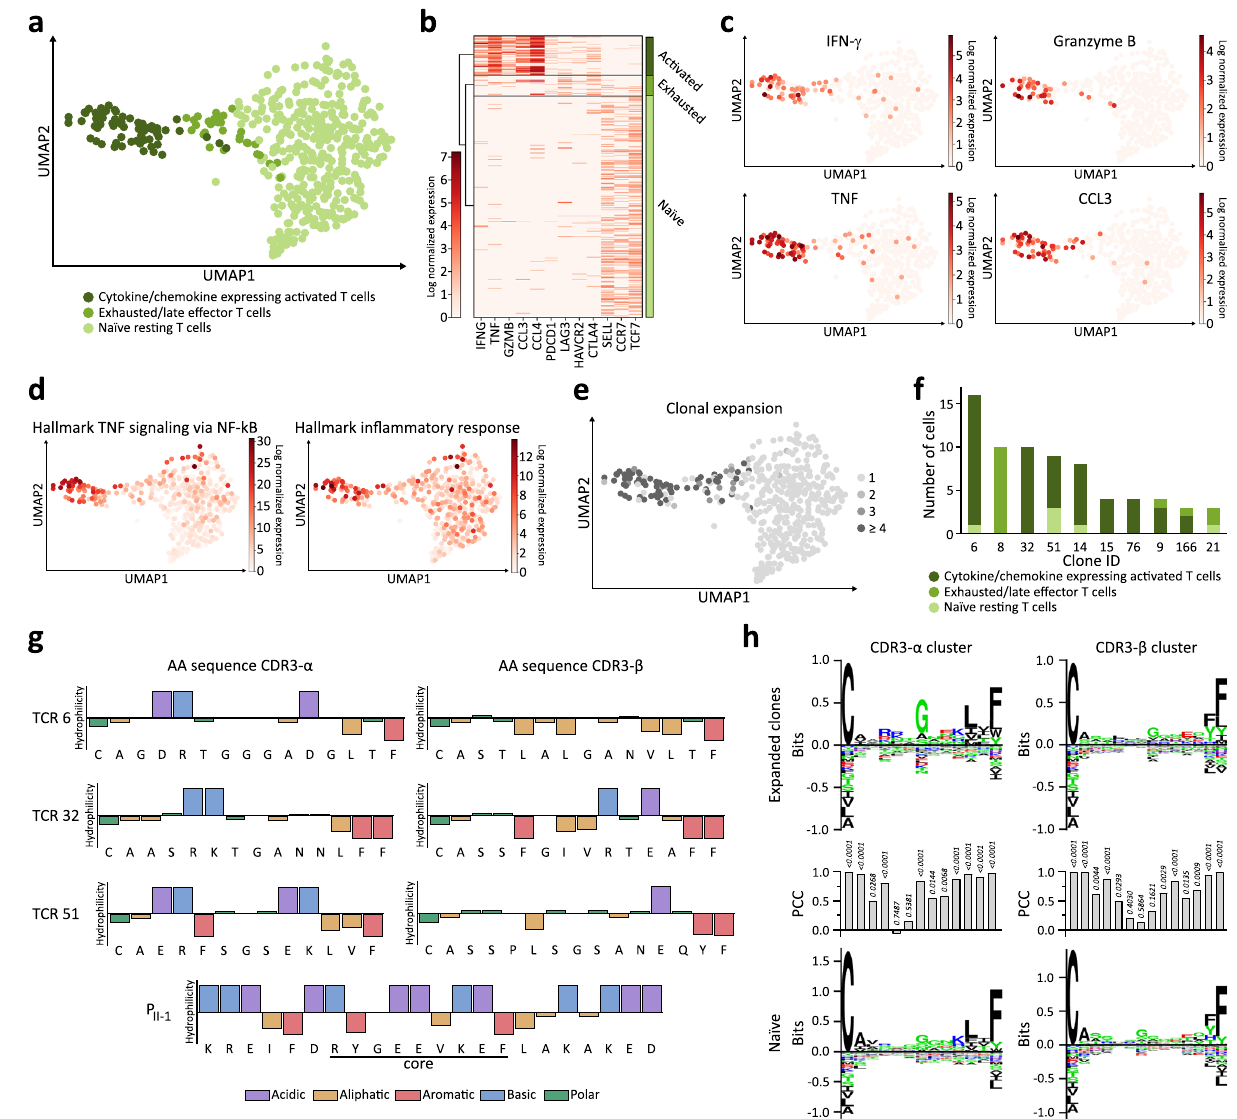
Fig.5|Single-cellRNAsequencingofvaccine-inducedP II-1 speci fi cCD4 + Tcells. a – f Single-cellRNA-sequencing analysis of CD4 + T cells sorted from P II-1 -stimulated PBMCs of the FL-HCC patient 31 weeks after the second vaccination with a perso- nalized DNAJB1-PRKACA-derived peptide vaccine. a Uniform Manifold Approx- imationand Projection (UMAP)plot showing distinctT cell clusters. b Heatmapof cluster de fi ning log normalized gene expression for activated, exhausted/late effector, and naïve resting T cells. c UMAP plots depicting log normalized IFNG, GZMB (encoding granzyme B), TNF, and CCL3 gene expression de fi ning the acti- vatedTcellcluster. d Functionalenrichmentofthelognormalizedgeneexpression for the hallmark cancer gene sets “ TNF signaling via NF- κ B ” and “ in fl ammatory response ” . e UMAPplotshowingTcellreceptor(TCR)clonalityofsequencedCD4 + T cells. The color code indicates the number of cells belonging to an expanded clonotype. f Distribution of the 10 largest TCR clonotypes across the cell type